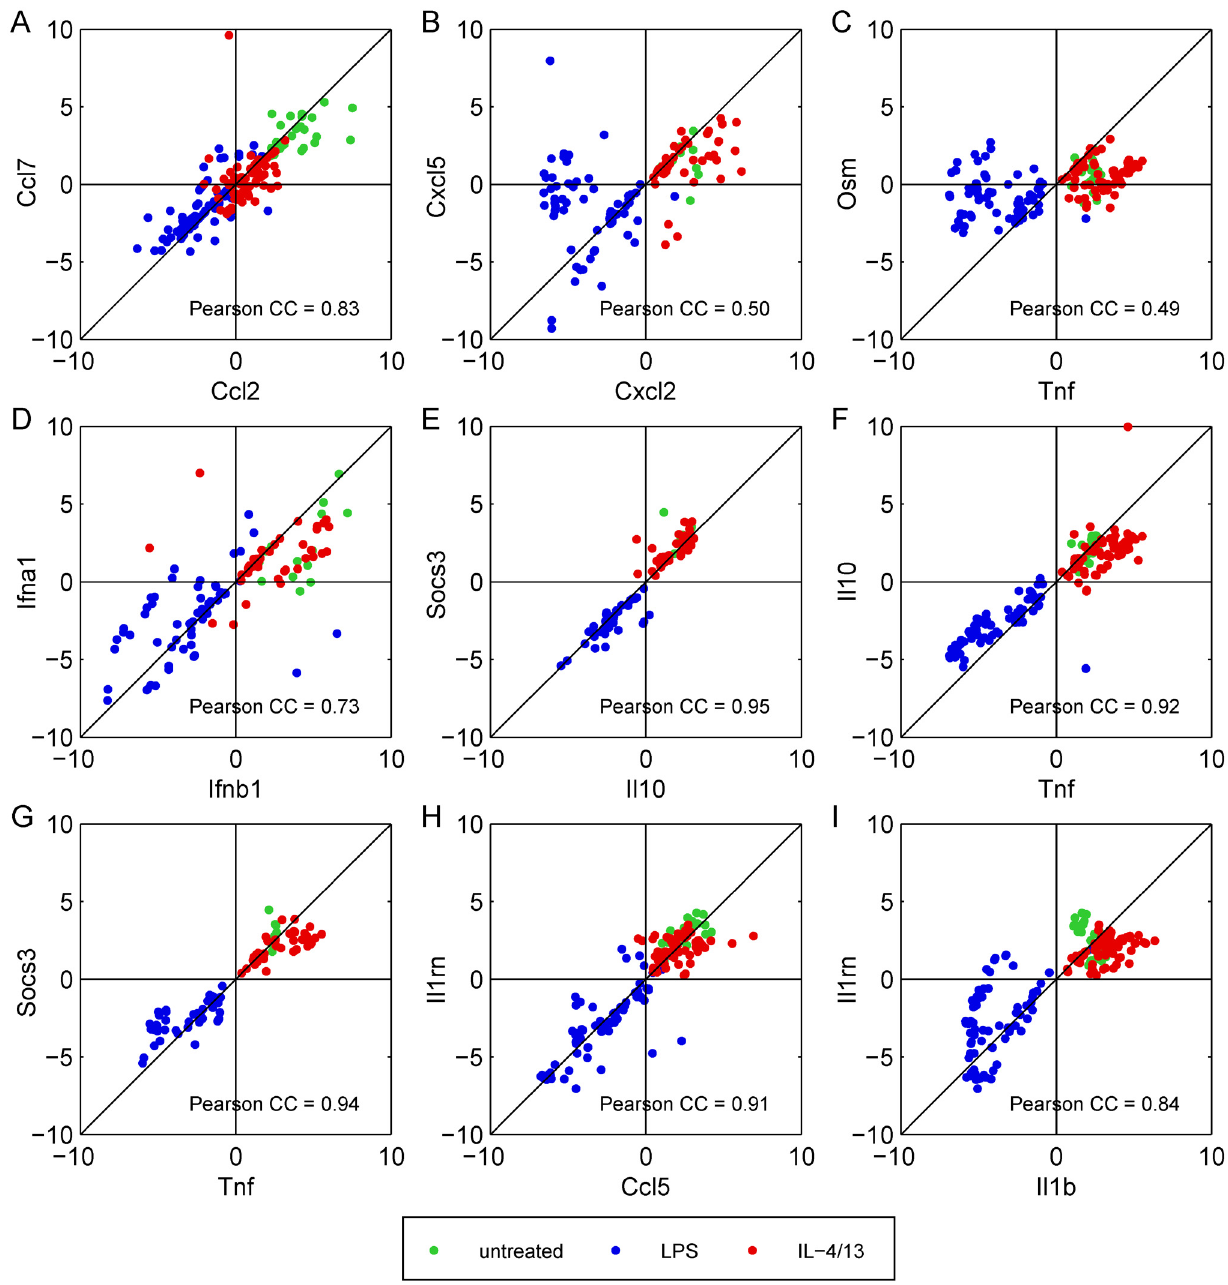
Fig 3. Co-expressed genes in macrophages. The scatter plots (A)-(I) indicate co-expression of the respective two genes if the Pearson ’ s correlation coefficient (CC) given is close to 1. For each gene, CT values minus mean expression value is